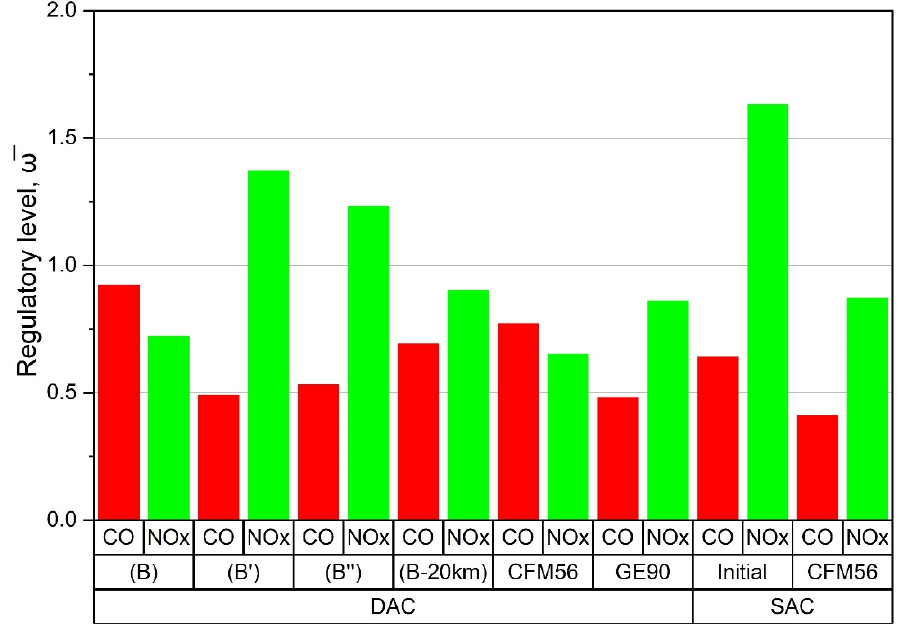
Figure 12. Comparison of SAC and DAC emissions with calculated values and real data from ICAO. Table 9. SAC and DAC emissions with calculated values and real data from ICAO.